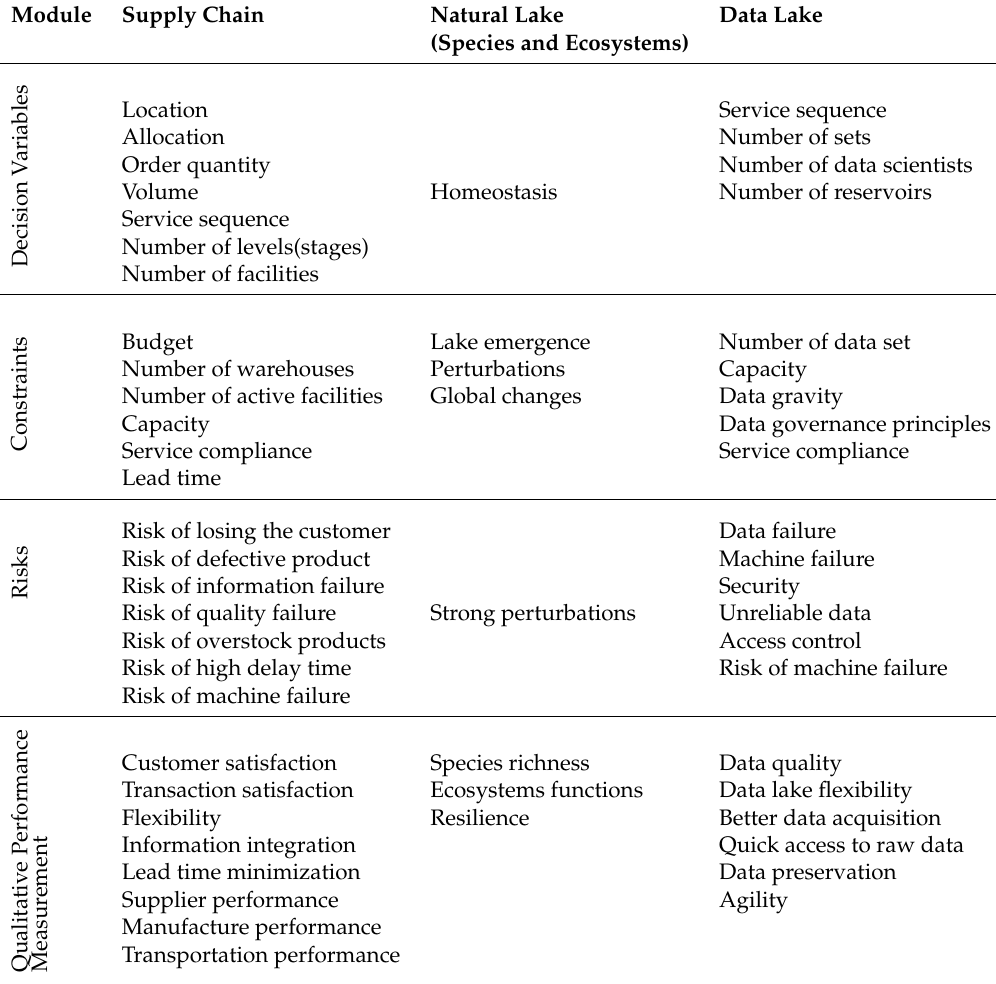
Table 2. Problem Specifications of Supply Chain, Ecosystem and Data Lake Module Supply